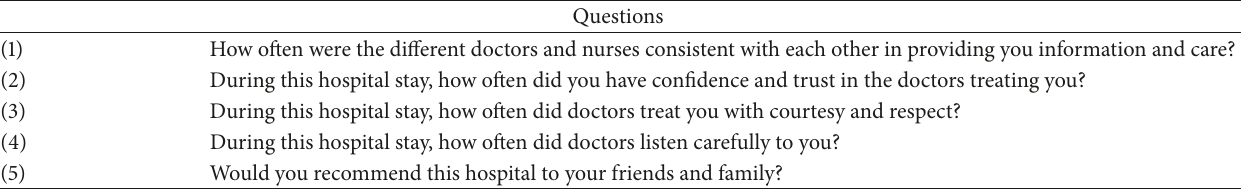
Table 1: Patient satisfaction